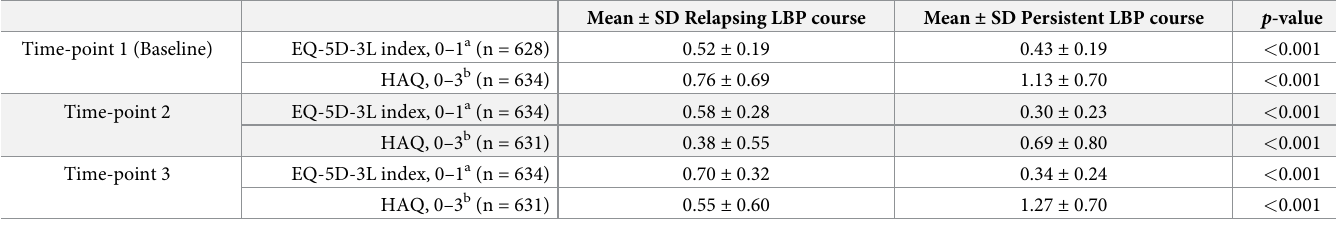
Table 2. HRQoL and disability at the different time-points, in “relapsing” and “persistent” LBP groups (n =